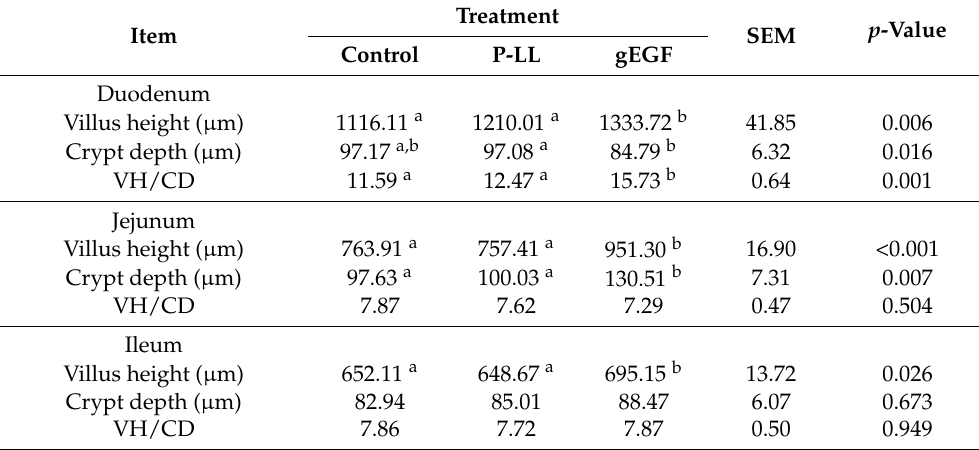
Table 5. Effects of gEGF on the mucosal morphological traits of the small intestines of treated broilers after two weeks of treatment. SEM: Standard Error of Mean. Data represented mean of 3 replications per treatment with 3 broilers per replication ( n = 3). Means within a row without superscripts (a or b) were of no significant difference ( p > 0.05). Means within a row with different superscripts (a or b) differed significantly ( p <